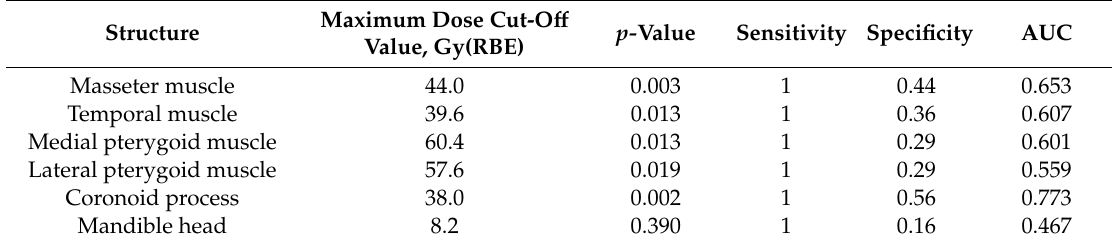
Table 1. Cut-o ff value of maximum dose for the onset of trismus in temporomandibular joint-related